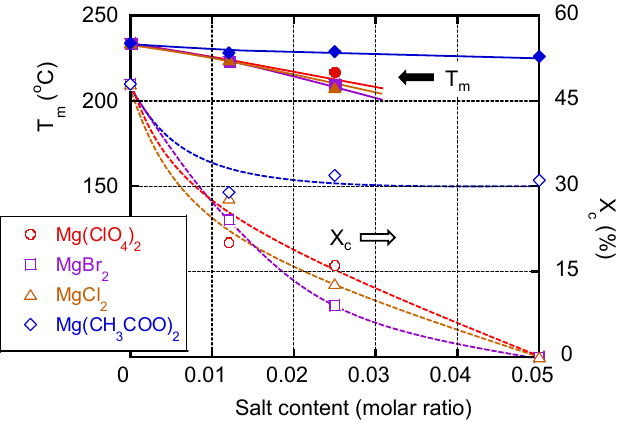
Figure 7. T m and X c plotted against the salt content; (circles) PVA/Mg(ClO 4 ) 2 , (squares) PVA/MgBr 2 , (triangles) PVA/MgCl 2 , and (diamonds) PVA/Mg(CH 3 COO) 2 PVA/MgBr 2 , (triangles) PVA/MgCl 2 , and (diamonds) PVA/Mg(CH 3 COO) 2 .